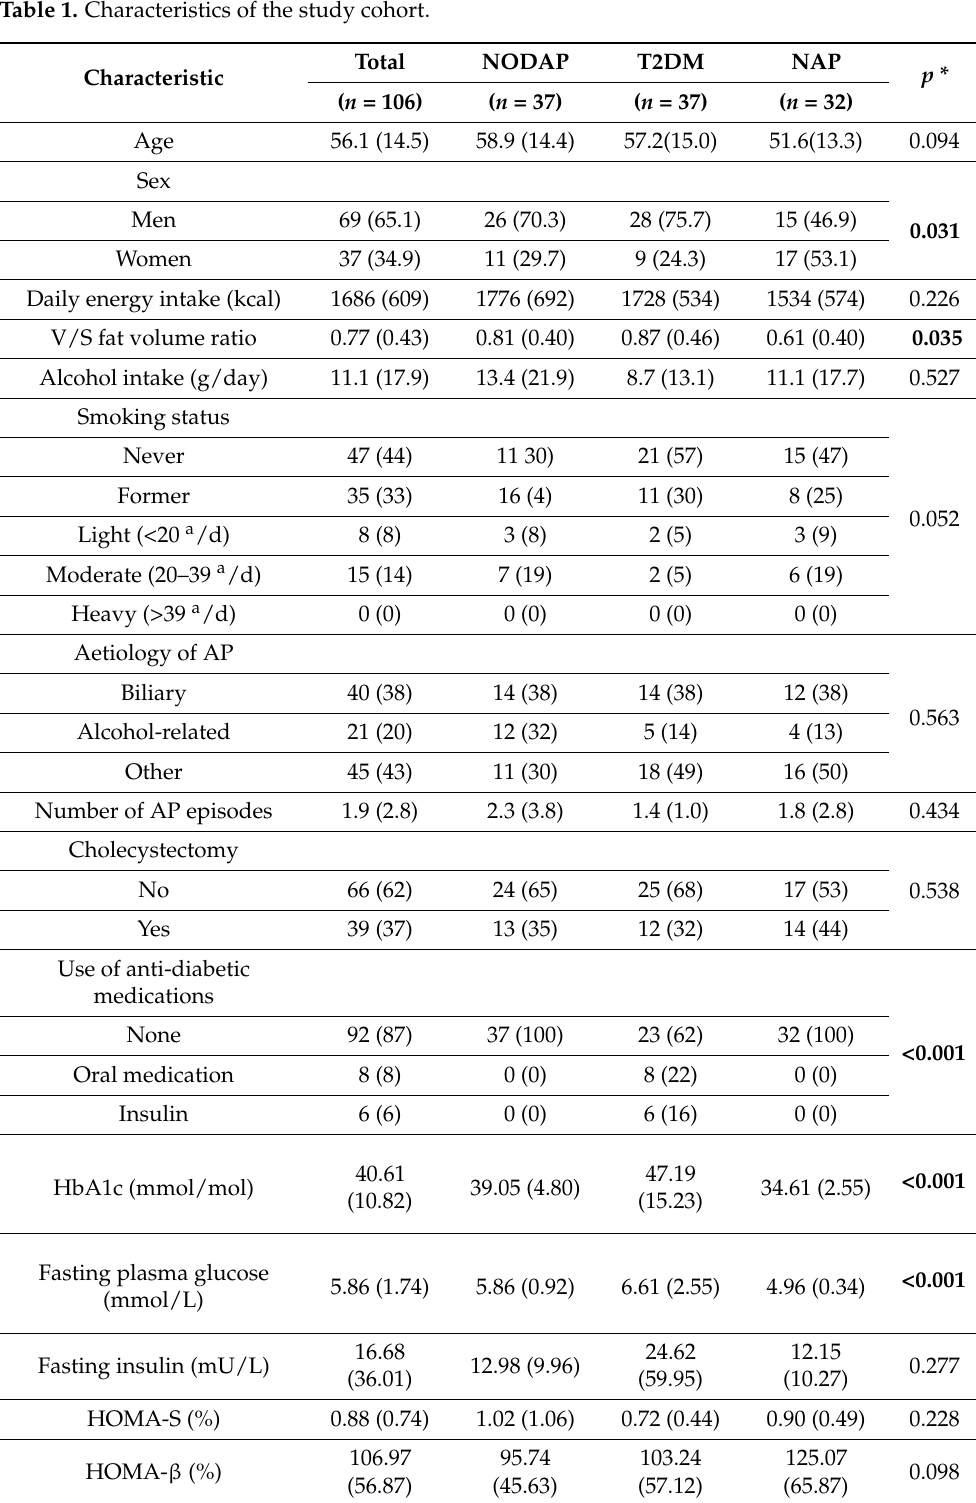
Table 1. Characteristics of the study